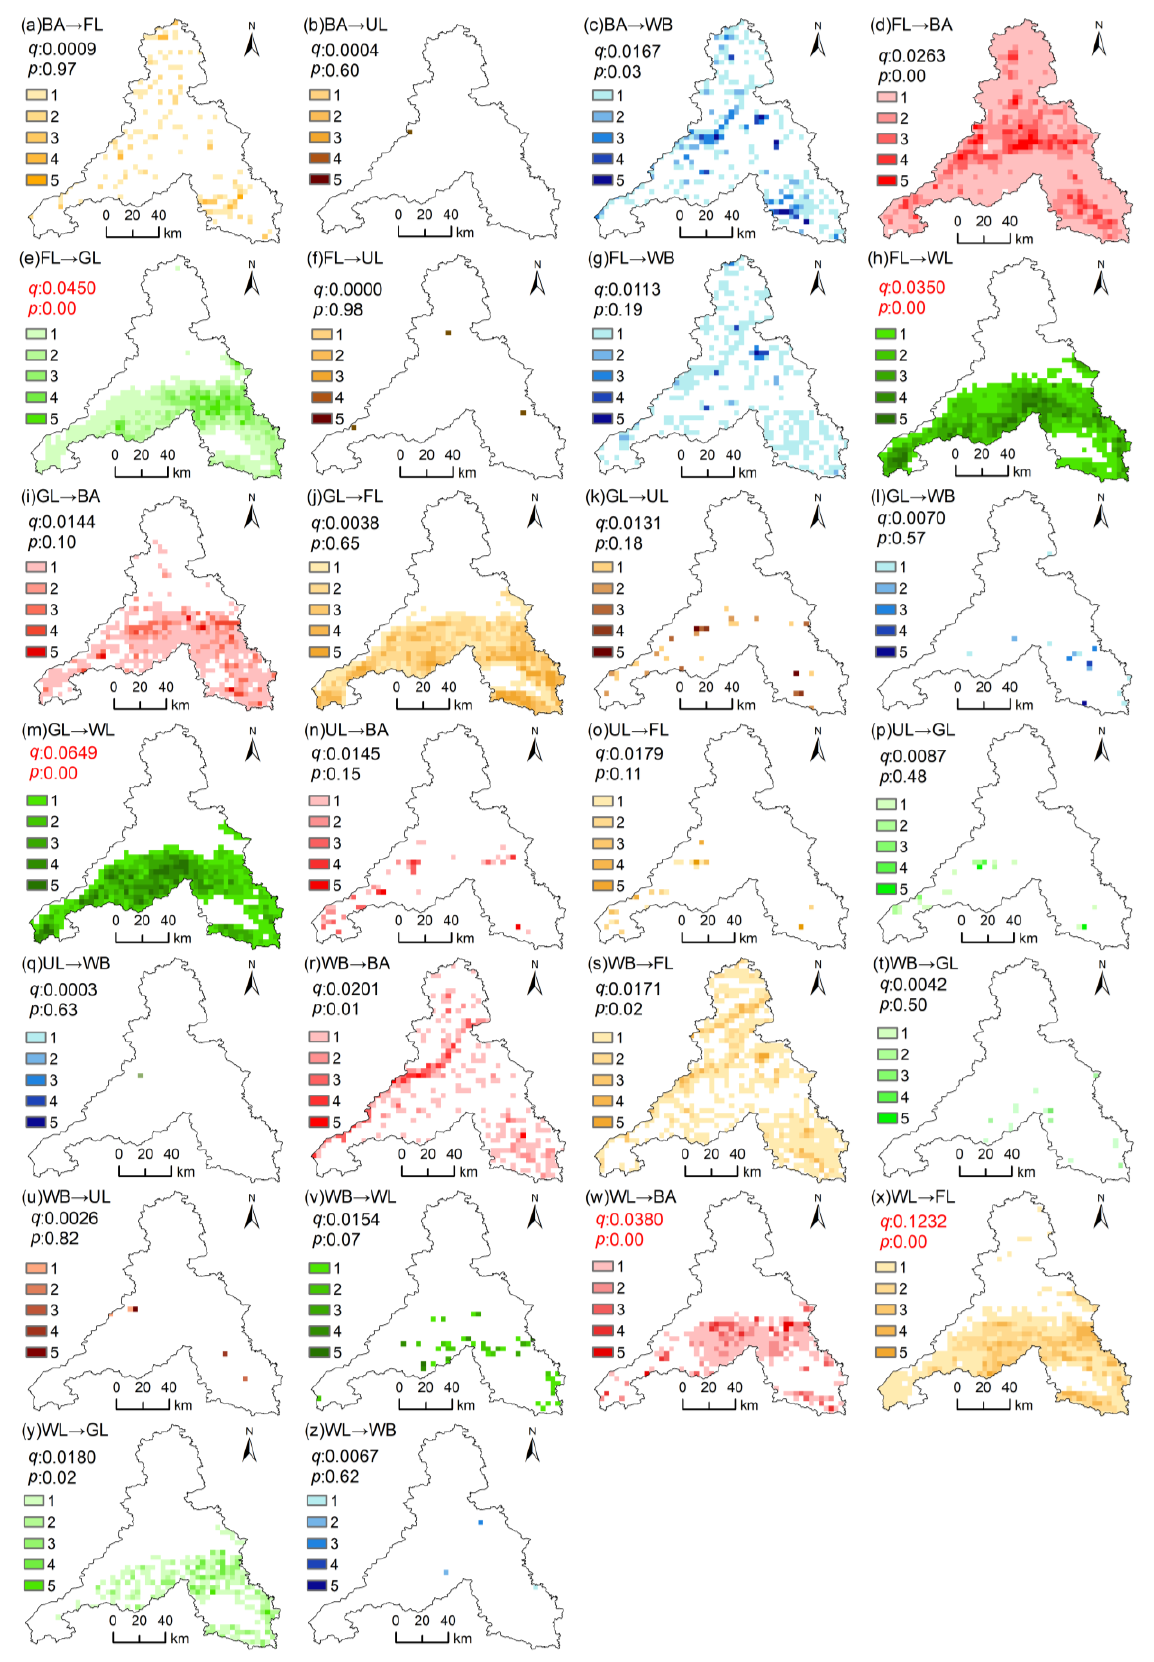
Figure 12. Factor detection results of ecological quality changes from 2010 to 2020: ( a ) – ( z ) show the spatial distribution of land use/land cover transfers from 2010 to 2020, respectively. The q and p values in each figure indicate the explanatory power and significance of that spatial distribution on ecological quality